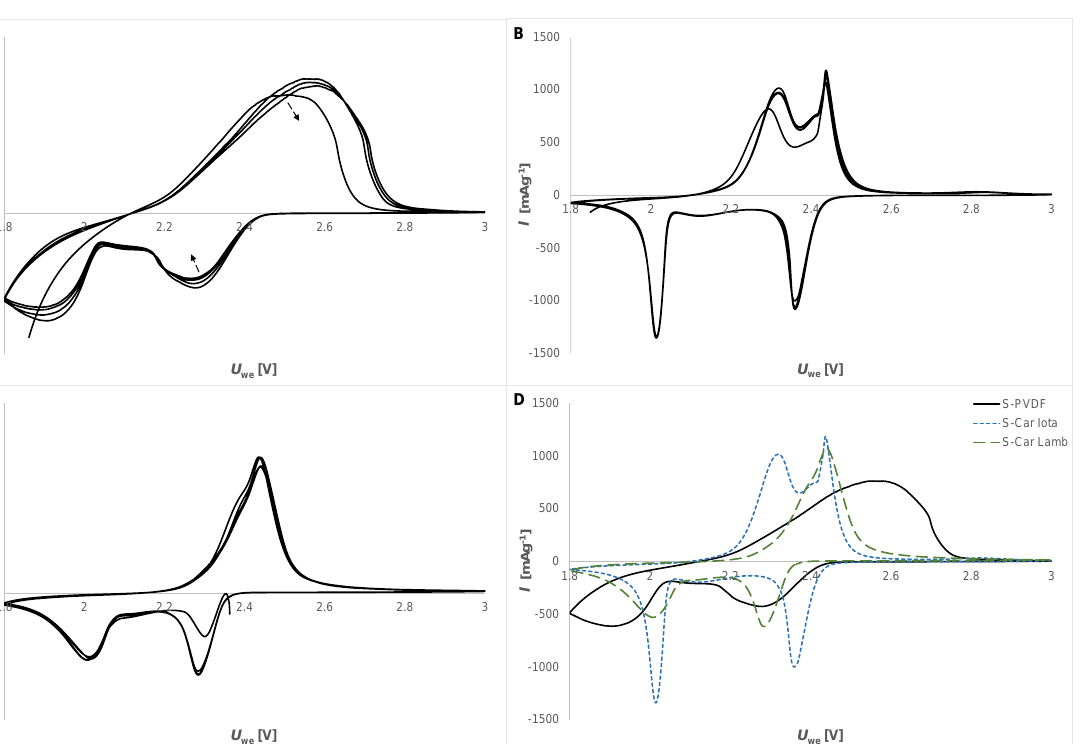
Figure 1. SEM images (field of view 10.4 µm) and EDS spectra of the electrode surface: ( A ) S-PVDF electrode surface, ( B ) S-Car-Iota electrode surface, ( C ) S-Car-Lamb electrode surface ( D ) S-PVDF EDS spectra, ( E ) S-Car-Iota EDS spectra, ( F ) S- Car-Lamb EDS spectra.